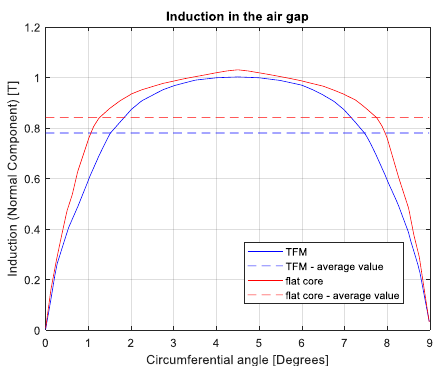
Figure 4. Comparison of the radial component of induction at half the air gap width for classic TFM and flat core design.